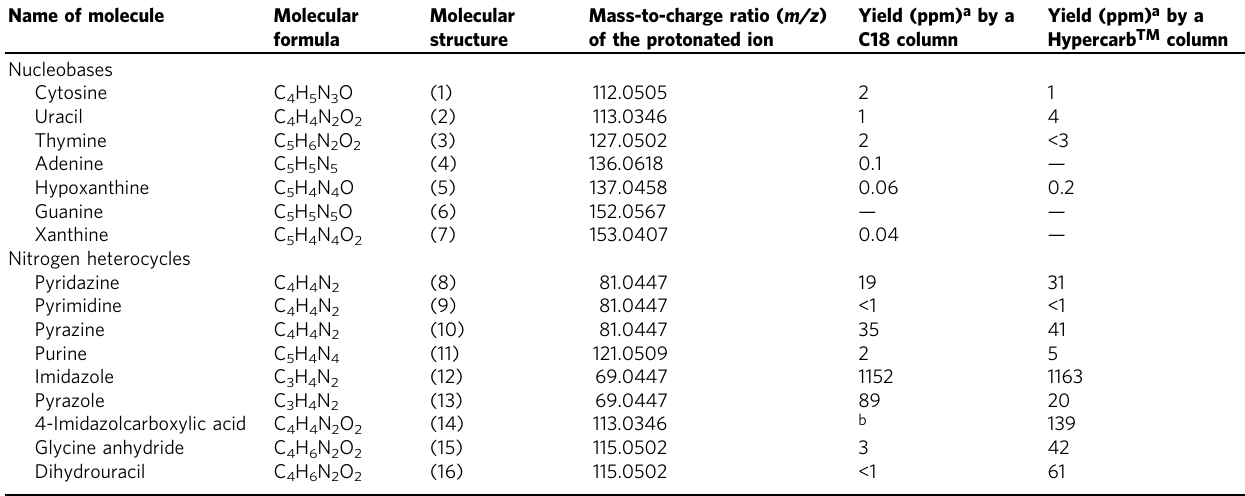
Table 1 Quanti fi cation results for the nitrogen heterocyclic molecules targeted in the present study